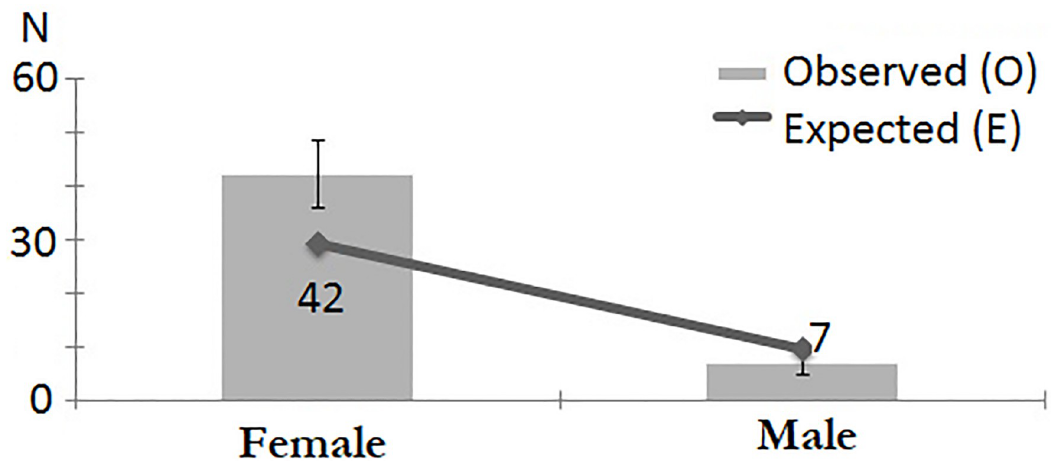
Fig 5. Gender distribution of JHS patients, as diagnosed with Beighton score.